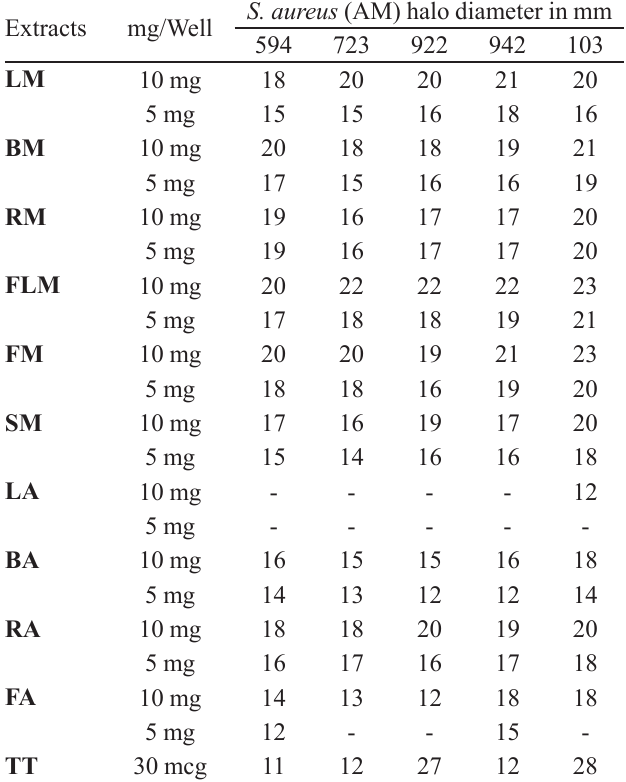
TABLE III - Antimicrobial activity of Caesalpinia pyramidalis against S.